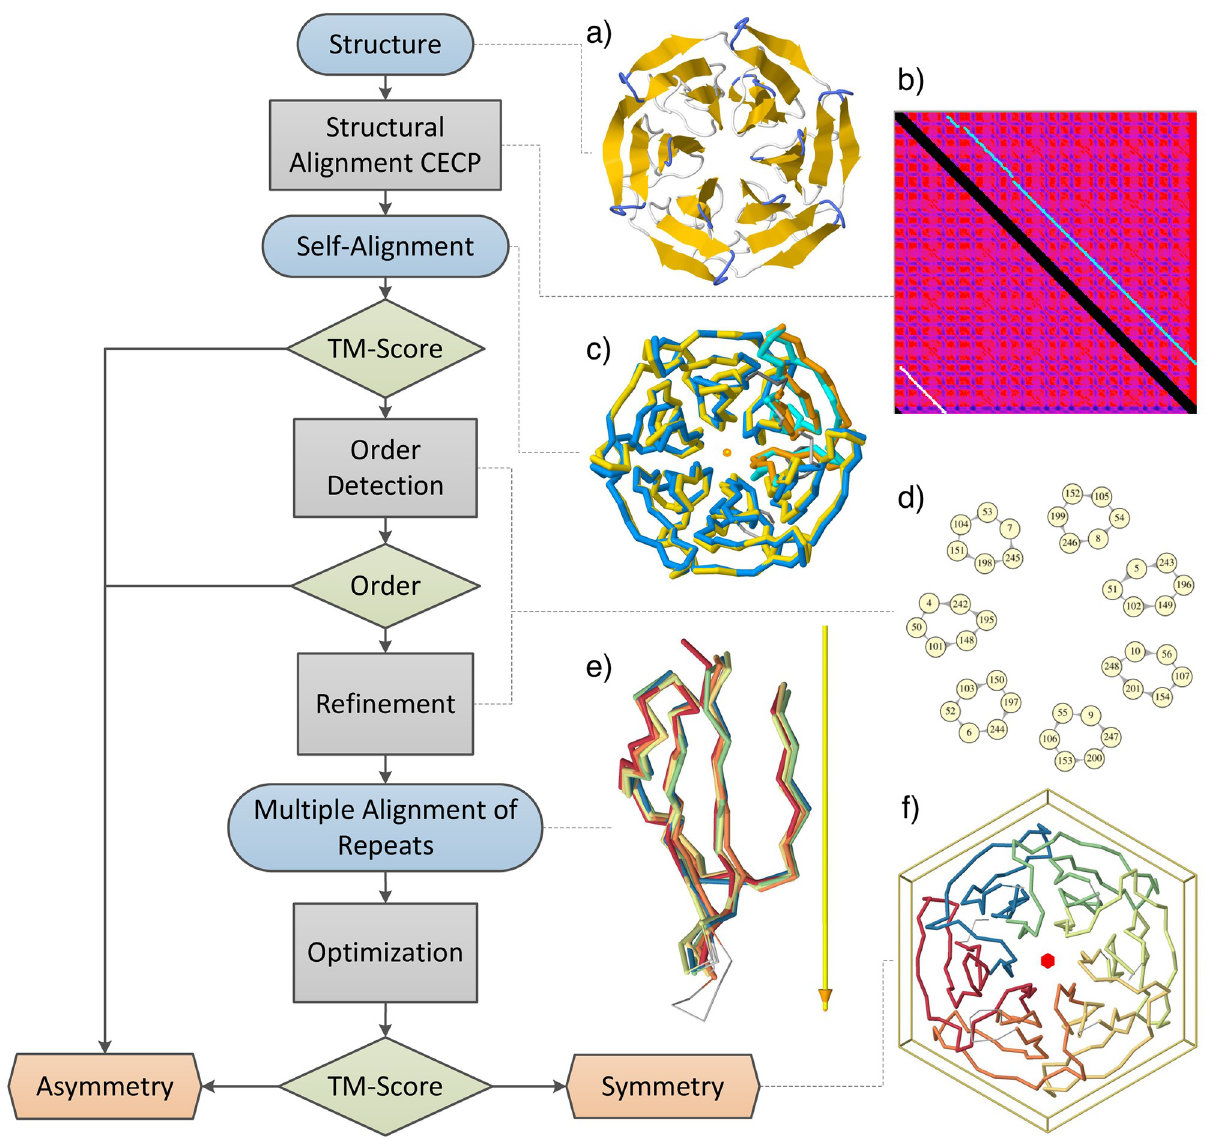
Fig 2. Flowchart of one iteration of the CE-Symm algorithm. Algorithm steps are grey rectangles, inputs and outputs are blue rounded rectangles, decision rules are green rhomboid boxes and final classifications are orange hexagonal rectangles. Additional iterations on the resulting repeats may be performed to detect further symmetry axes or hierarchical symmetry. The images on the right represent, from top to bottom: a) initial structure, colored by secondary structure elements; b) self-alignment dot-plot matrix, where similarity score is a range from blue (high similarity) to magenta (low similarity), the identity alignment is blacked out and the optimal self-alignment path is in white; c) superposition of the structure against itself based on the optimal self-alignment, where the original structure is in blue and cyan and a copy of the structure is in yellow and orange (orange and cyan correspond to the regions of the alignment involving a circular permutation); d) subset of the alignment graph with seven connected components of six aligned residues each; e) superposition of the six internally symmetric repeats according to the symmetry axis (yellow bar) and their residue equivalencies; and f) structure inside the six-fold cyclic symmetry (C6) box, with repeats colored differently.